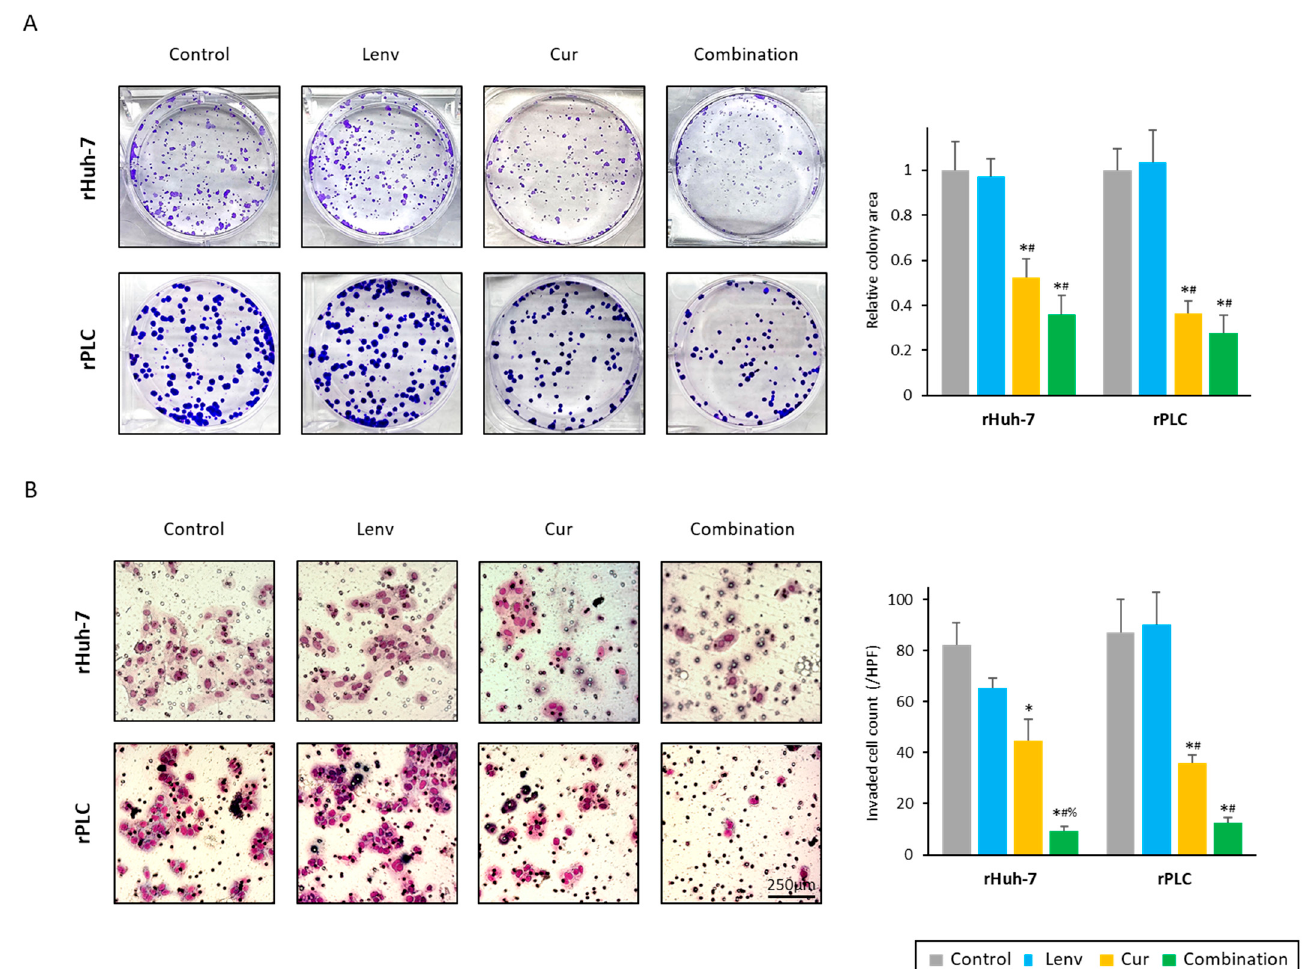
Figure 3. Curcumin reversed Lenvatinib resistance by inhibiting colony formation and invasion in HCC cell lines. ( A ) Colony formation assays for Lenvatinib ‐ resistant cells following treatment (*: p < 0.05 vs. control, #: p < 0.05 vs. Lenvatinib). ( B ) Invasion assays following treatment in Lenvatinib ‐ resistant cells. Scale bar = 250 μ M. The number of invaded cells were randomly counted at three microscopic fields per membrane (*: p < 0.05 vs. control, #: p < 0.05 vs. Lenvatinib, %: p < 0.05 vs. Curcumin). Images show representative fields on the membrane (magnification × 400). The data indicate mean (column) ± SD values. SD, standard deviation.